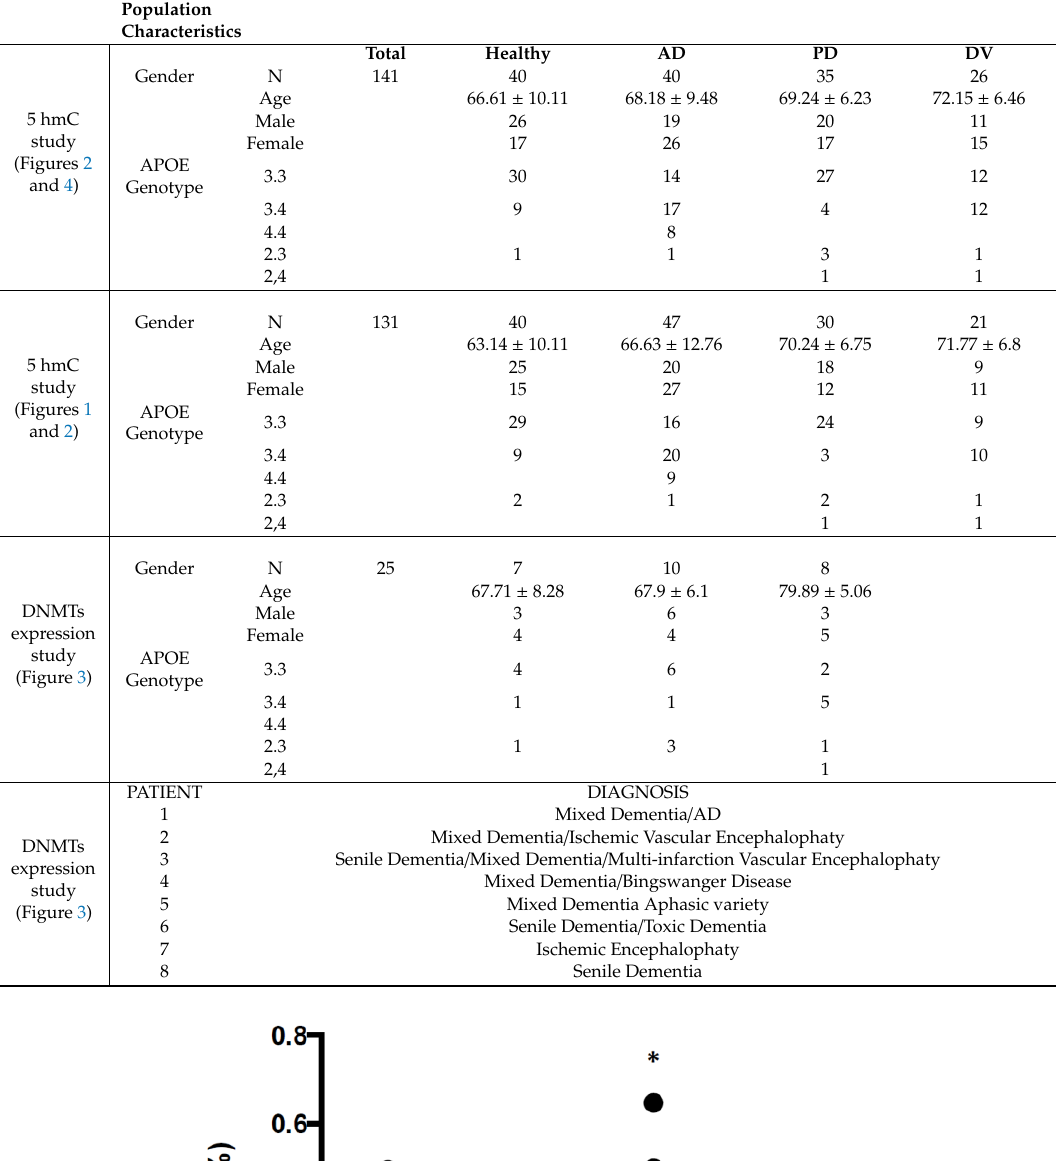
Table 1. Patient’s characteristics.